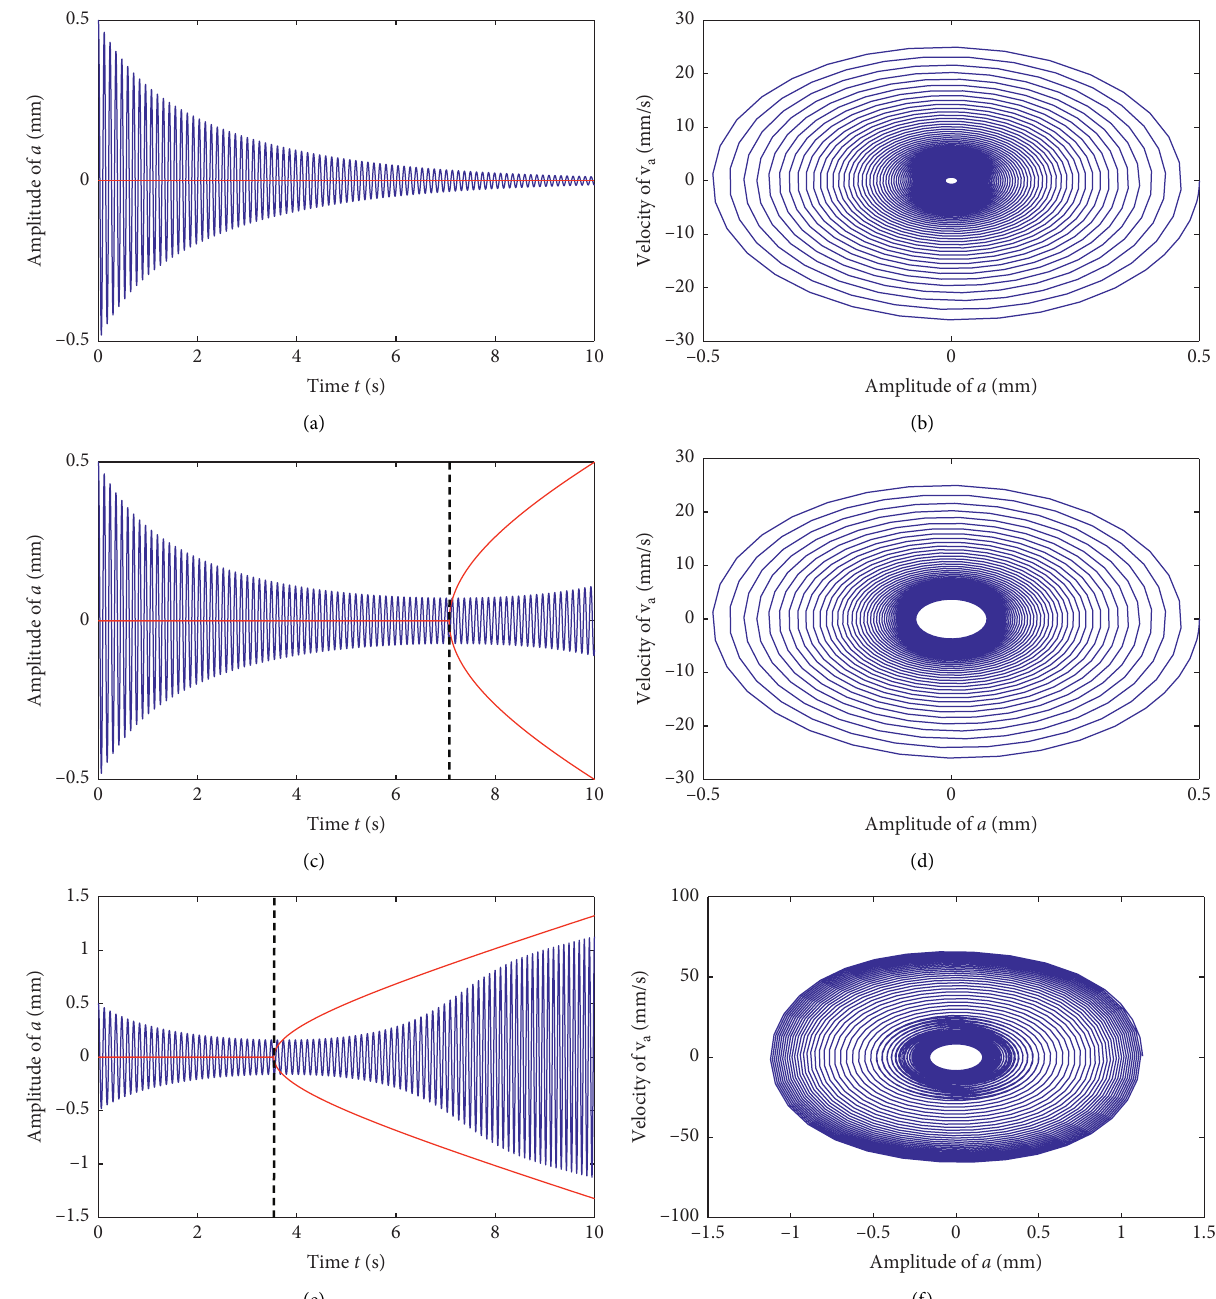
Figure 8: Time domain and phase diagrams: (a) r � 7, (b) r � 7, (c) r � 400, (d) r � 400, (e) r � 700, and (f) r �